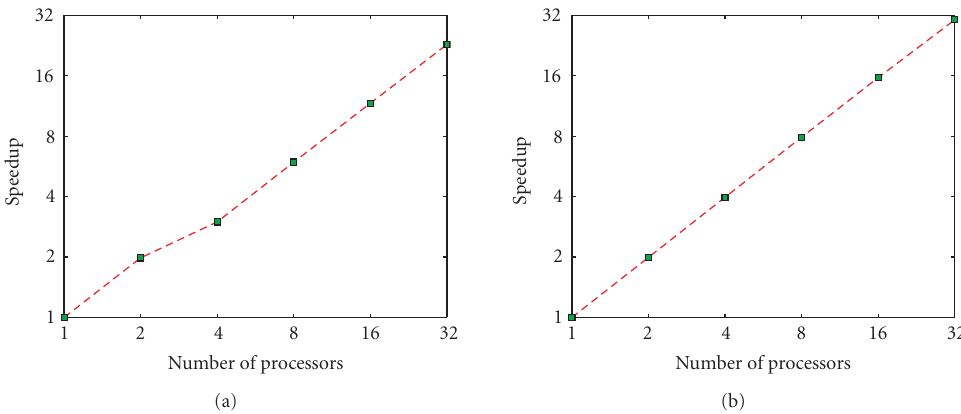
Figure 7: (a) Speedup with the uniform partition of I ; (b) speedup with the nonuniform partition of I . The speedup with the nonuniform partition of I is better than that with the uniform partition of I